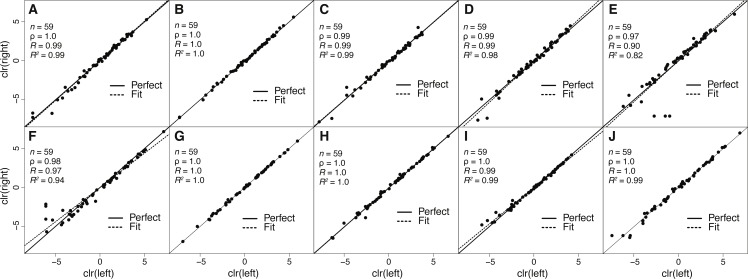
Estimates of toxin expression levels match nearly exactly across left and right glands of individual snakes.The solid diagonal line corresponds to perfect agreement. All rank correlations were ≥0.97, and all linear correlation coefficients were ≥0.90, with nine of ten ≥0.97. (A) Apalachicola National Forest adult (ANF-A, KW1264). (B) Brooksville Ridge adult (BR-A, MM0127). (C) Caladesi Island adult (CAL-A, KW1942). (D) Everglades National Park adult (ENP-A, KW0944). (E) Little St. George Island adult (LSG-A, KW2161). (F) Apalachicola National Forest juvenile (ANF-J, MM0198). (G) Brooksville Ridge juvenile (BR-J, KW2171). (H) Caladesi Island juvenile (CAL-J, KW2170). (I) Everglades National Park juvenile (ENP-J, MM0143). (J) Little St. George Island juvenile (LSG-J, KW2184). Abbreviations: clr, centered logratio; n, number of transcripts; ρ, Spearman’s rank correlation coefficient; R, Pearson’s correlation coefficient; R2, coefficient of determination.